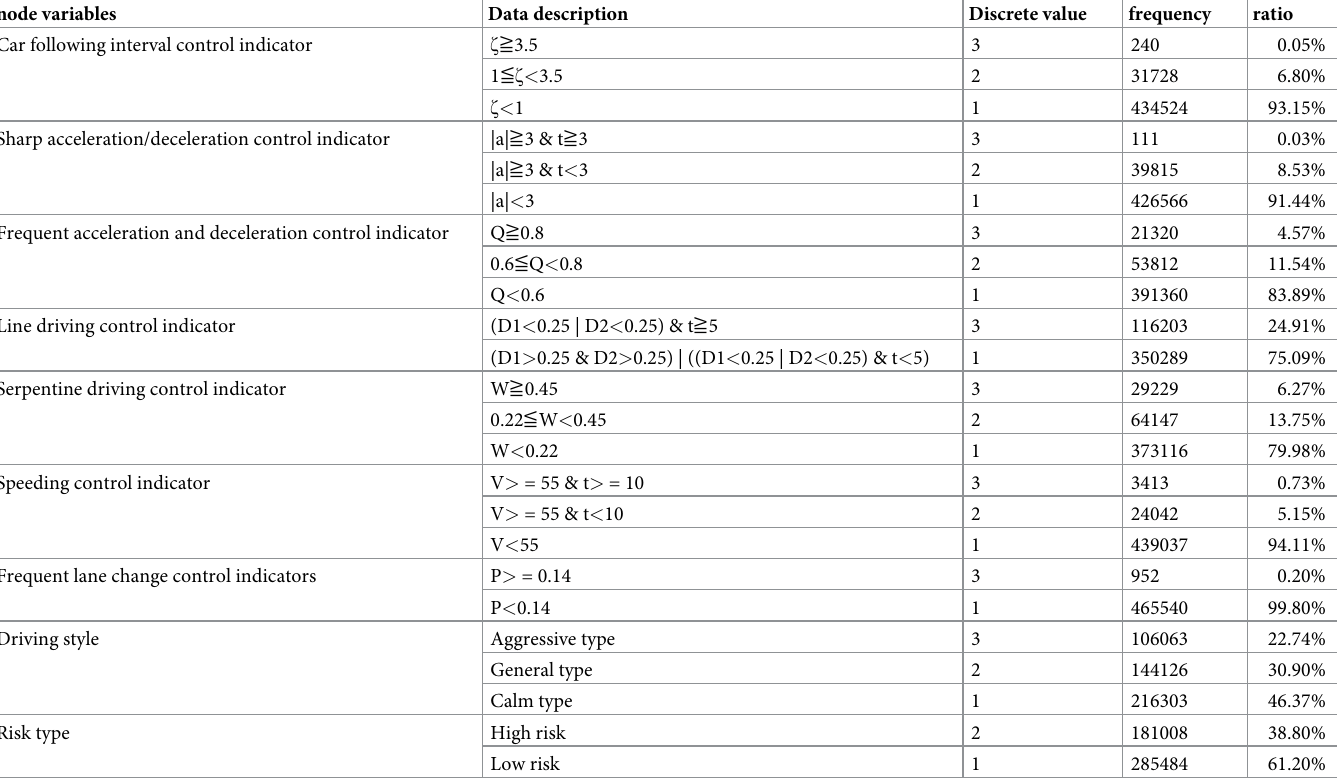
Table 4. Bayesian network node variables and their discrete values.